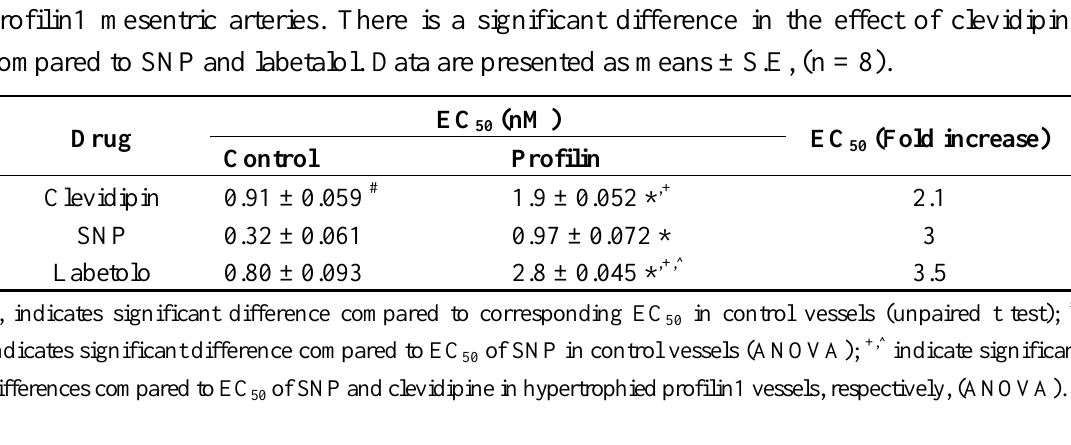
Figure 4. Comparative analysis of the effects of clevidipine, SNP and labetalol on phenylephrine-pre-contracted hypertrophied profilin1 mesenteric arteries. There is a significant difference in the effect of clevidipine compared to SNP and labetalol. While we need only to increase the clevidipine EC50 two fold in the profilin1 to obtain the same degree of relaxation of its control, the SNP and labetalol needed to be increased 3 and 3.4 times respectively to obtain the same relaxing effects as seen in their